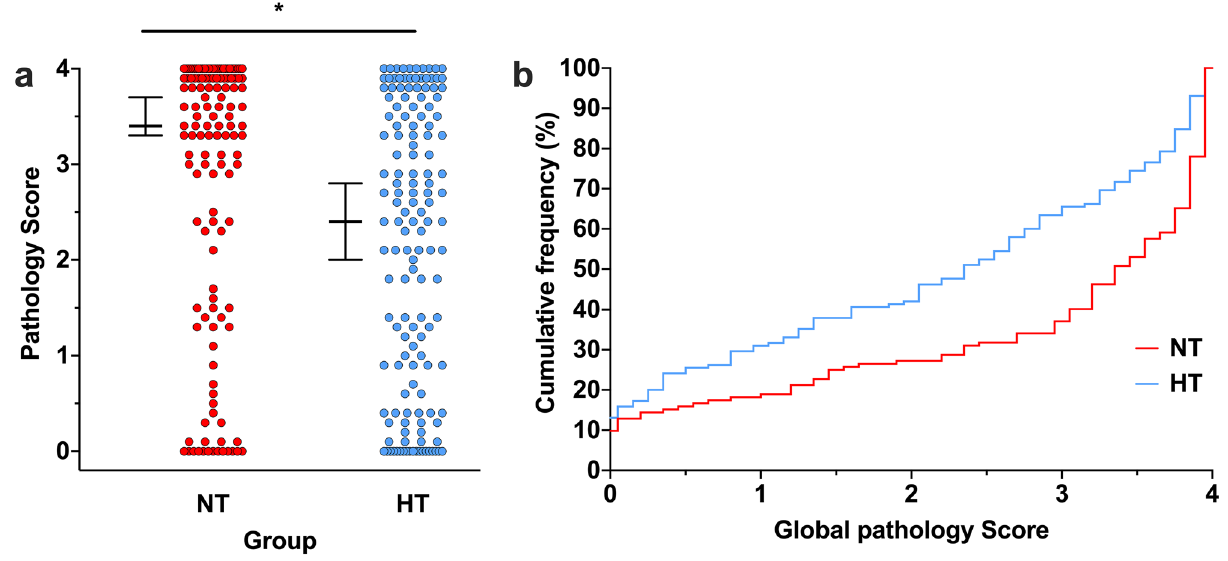
Figure 3. Global pathology scoring. ( a ) In the subset of animals that underwent formal pathology scoring (n = 277; n = 132 NT, n = 145 HT), median (95% CI) global pathology score 3.4 (3.3–3.7) in the NT group, and 2.4 (2.0–2.8) in the HT group. *Denotes significant neuroprotection ( p < 0.001). ( b ) Cumulative frequency plot from the NT (n = 132) and HT (n = 145) groups, with each observation resulting in a proportional increase in the y-axis. A relatively uniform degree of neuroprotection is seen across the whole range of injury severity, with increasing relative neuroprotection in the HT group up to a global pathology score of